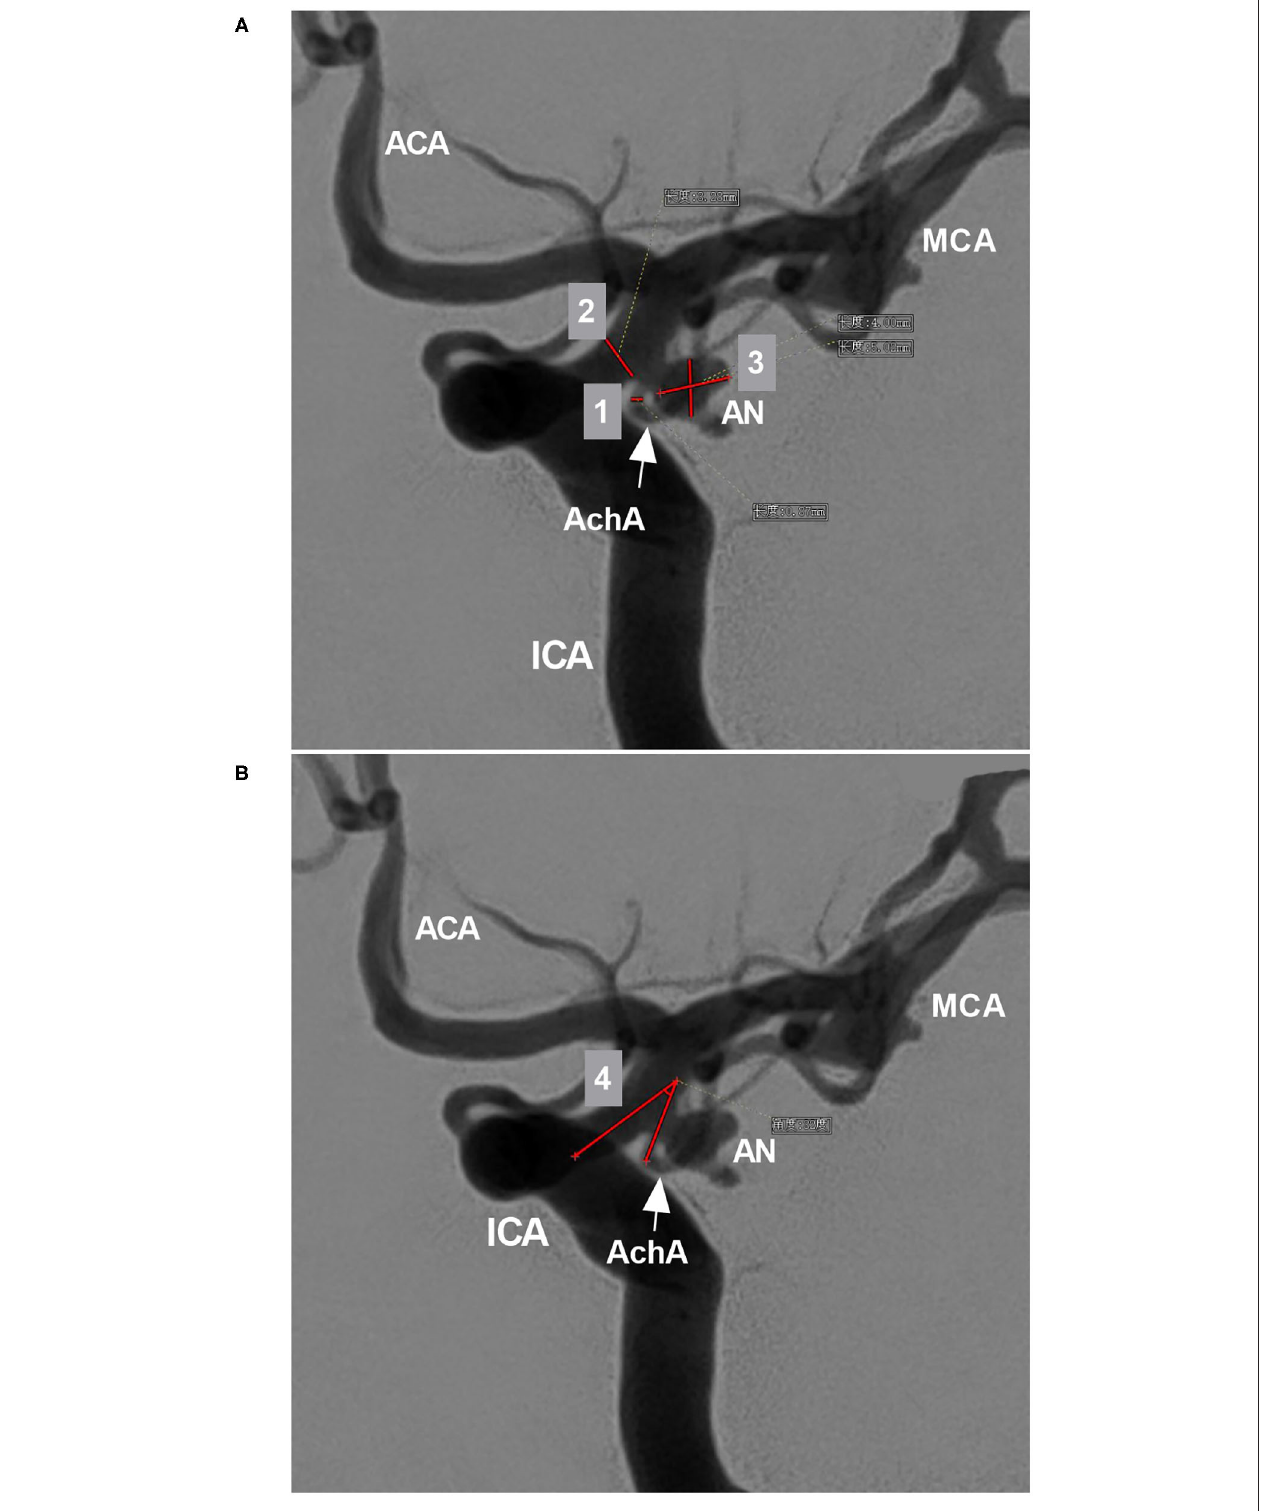
FIGURE 2 | Parameter measurement. (A) DSA showing the measurement diameters: number 1 refers to the diameter of the AchA at the origin (arrow), number 2 refers to the diameter of the ICA at the AchA origin, and number 3 shows the measurement of the width and length of the aneurysm (AN). (B) DSA showing the degree (number 4) between the ICA and AchA at the origin (arrow). ACA, anterior cerebral artery; AchA, anterior choroidal artery; AN, aneurysm; DSA, digital subtraction angiography; ICA, internal carotid artery; MCA, middle cerebral artery.